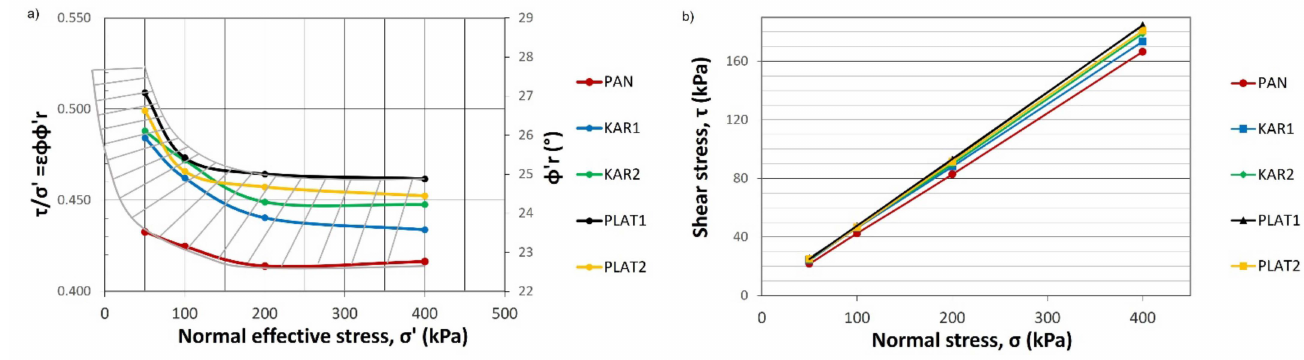
Figure 8. ( a ) Variation of residual friction angle with effective normal stress ( b ) residual strength envelops measured by Bromhead ring